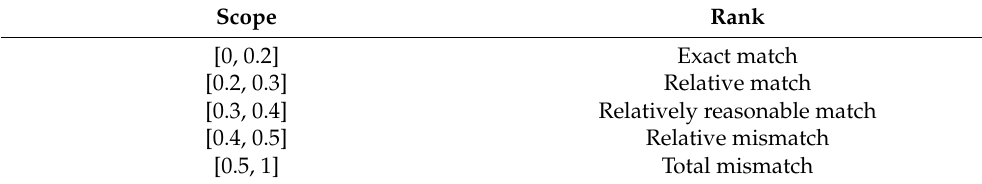
Table 5. Thresholds of the Gini